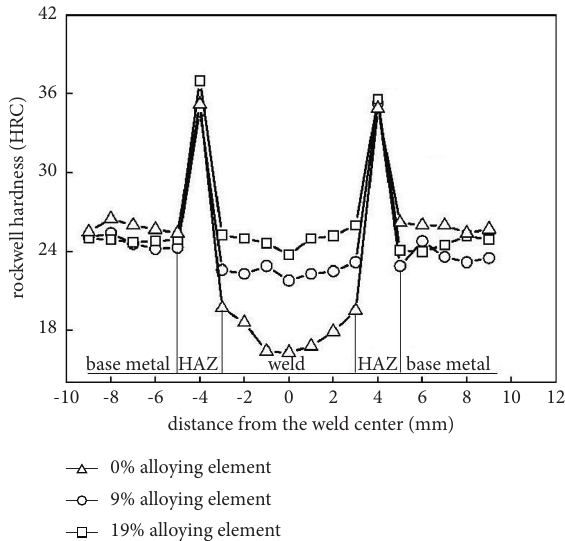
Figure 6: Hardness of rail steel versus distance to the center of the weld. Table 3: Effect of flux formulation on the ultimate tensile strength of the weld joints.